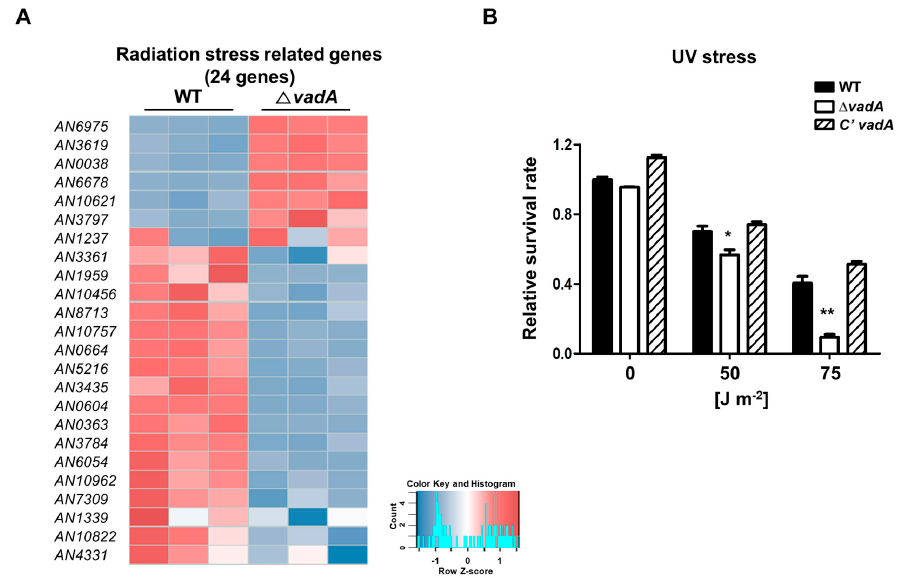
Figure 4. Role of vadA in the UV-mediated stress response. ( A ) Heat map showing the DEGs with UV stress response. ( B ) The tolerance of control (THS30), Δ vadA (THS33), and C’ vadA (THS34) conidia against UV irradiation. About 10 2 conidia were irradiated with 50 or 75 J/m 2 of UV at 260 nm (triplicate measurements). Error bars represent the standard deviation (differences between the vadA mutants and control strains). ** p < 0.01; * p < 0.05.